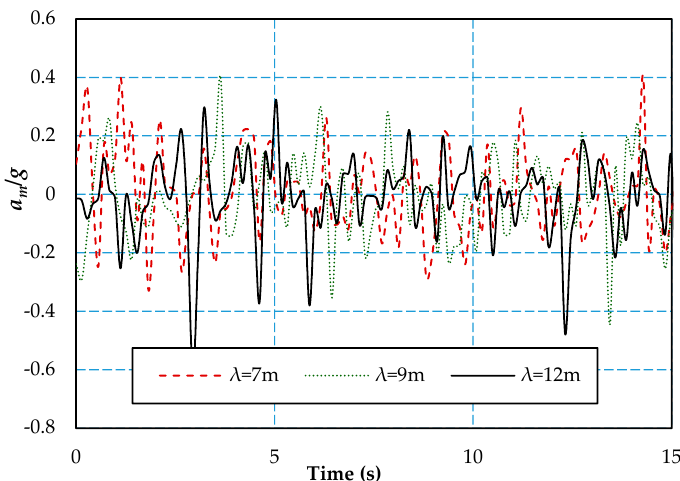
Figure 15. Oscillation curves of pitch in different wavelengths.